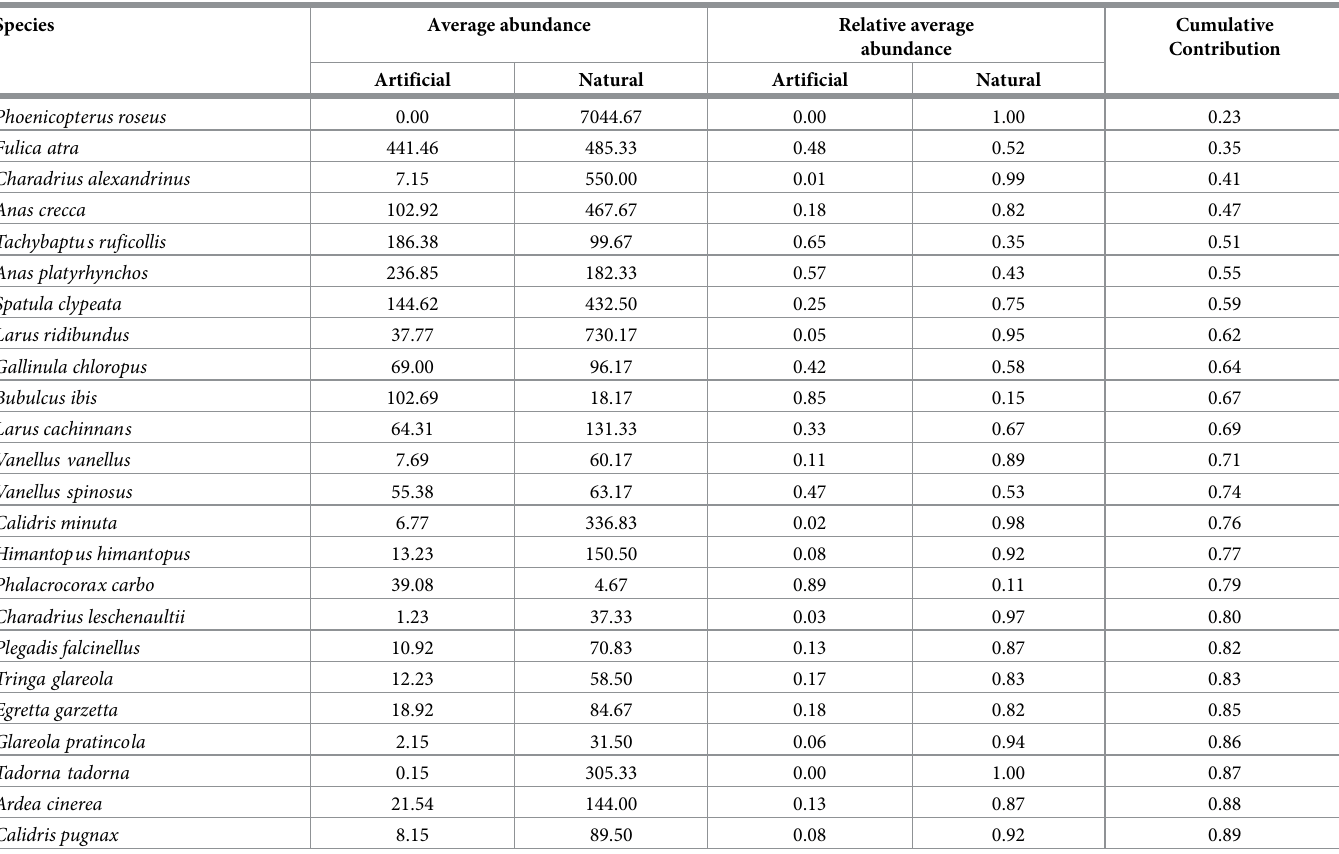
Table 2. The list of species accounting for 90% of the dissimilarity in species composition between artificial and natural wetlands in 2011, when abundances are used. For each species, the average and the relative average abundances in each wetland type are shown, along with the cumulative contribution to the Bray-Curtis dissimi- larity